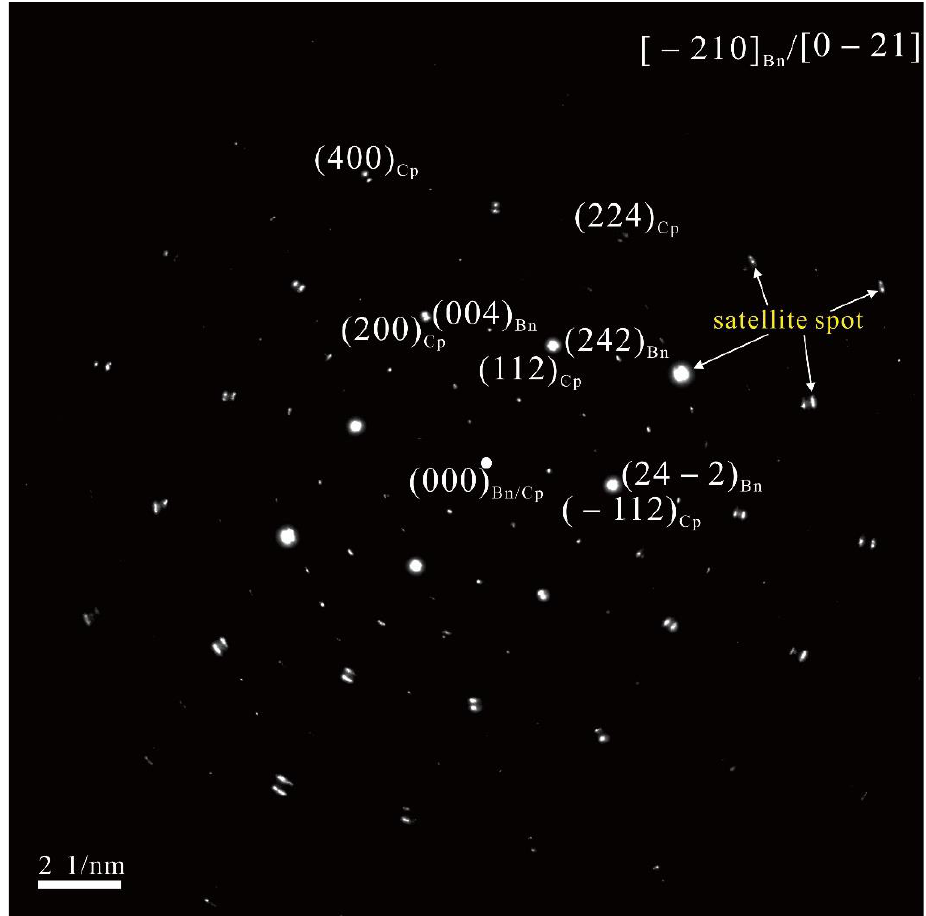
Figure 5. The electron diffraction of spinodal decomposition, showing satellite spots along the [ − 210] direction for bornite.